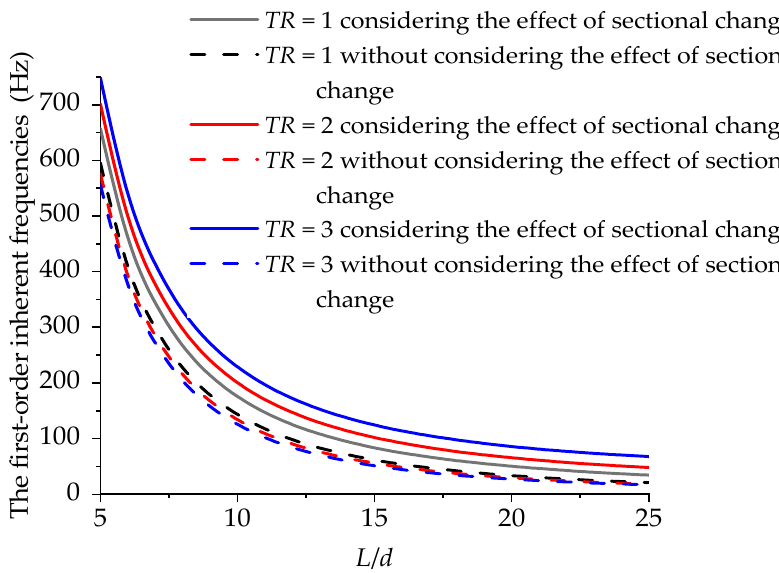
Figure 9. Variations in the first-order inherent frequencies of the boring bar with the length-to- diameter ratio under different TR values ( ψ = 0). Table 2. Effect of the change of the length-to-diameter ratio on the first-order inherent frequency of the boring bar under different TR values ( ψ =